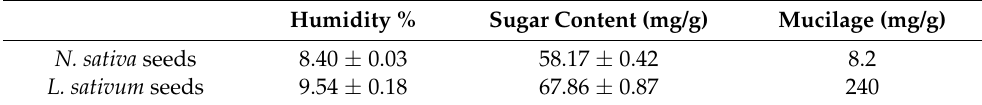
Table 1. Humidity, sugar content, and mucilage of both seed extracts.